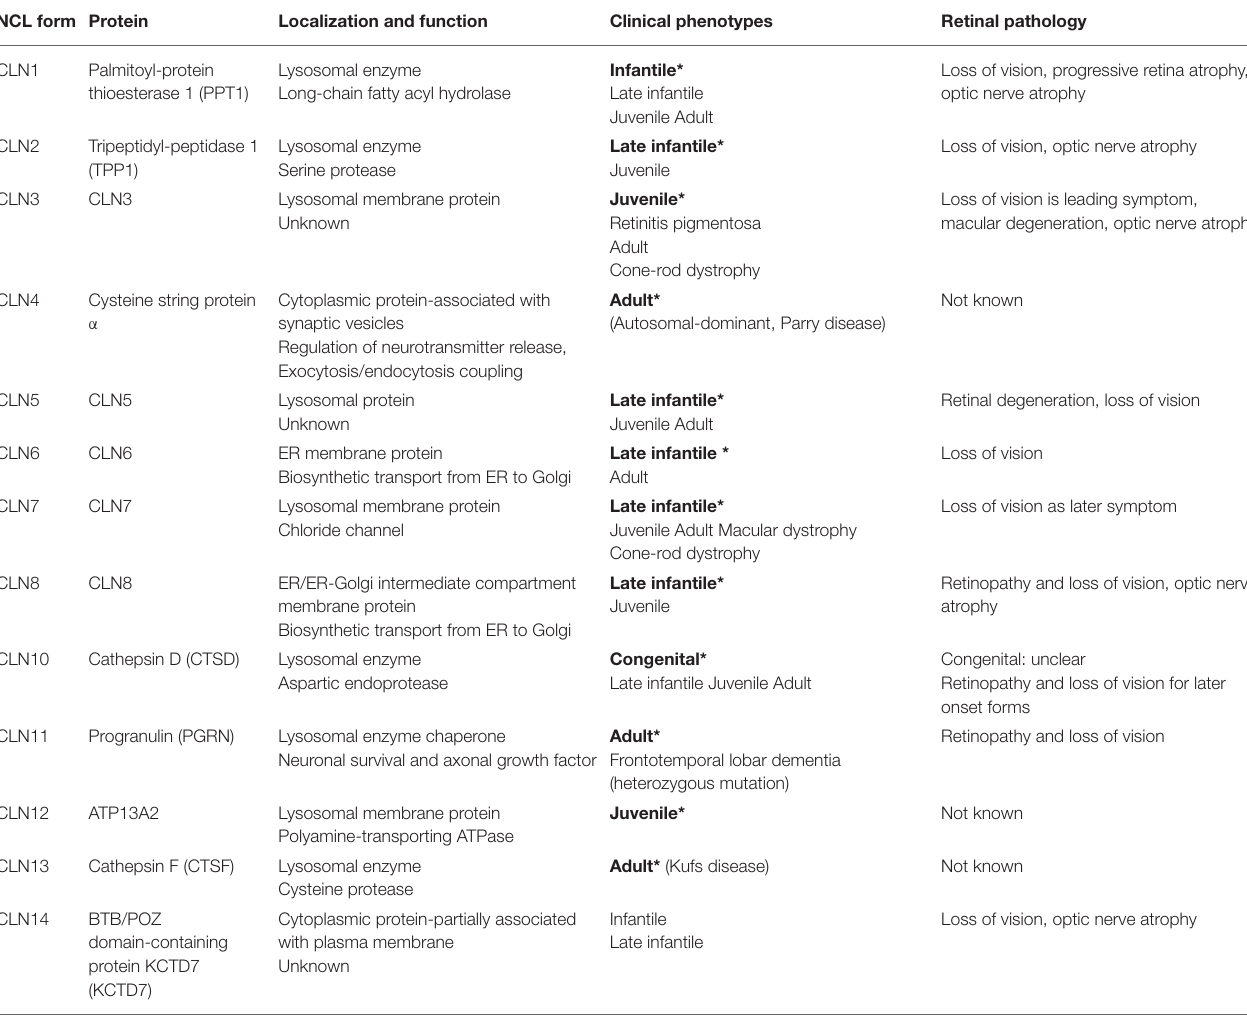
TABLE 1 | Summary of NCL forms, localization and function of gene products and retinal pathology in human patients. NCL form Protein